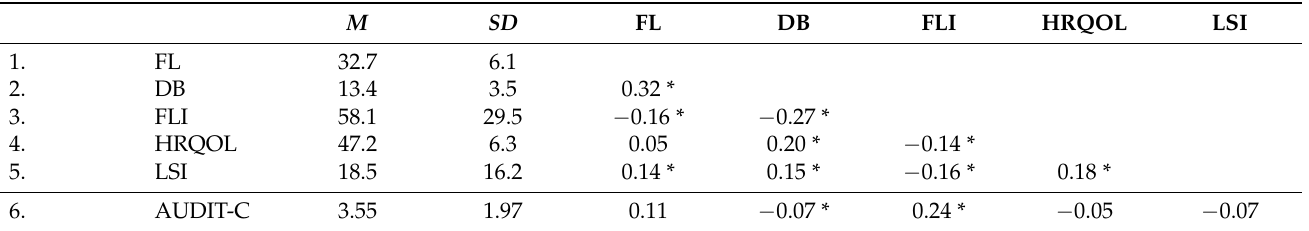
Table 2. Means, SD s, and bivariate correlations for FL, DB, FLI, HRQOL, and alcohol